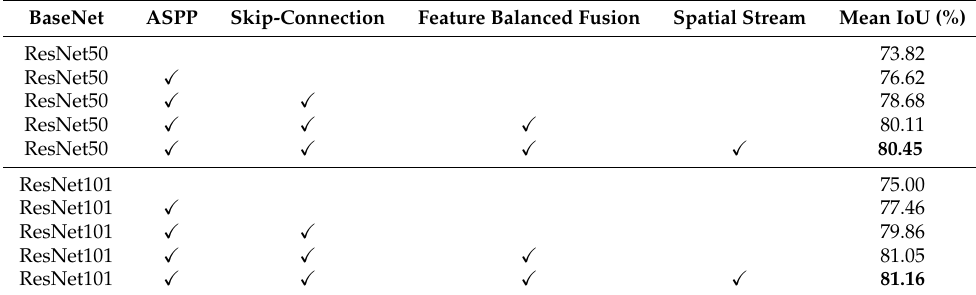
Table 2. Ablation experiments on ASPP, our inter-level feature balanced fusion module, and shape stream over the ResNet50 and ResNet101 base networks on the Cityscapes validation set. The blackened numbers represent the best performing group in this set of data.